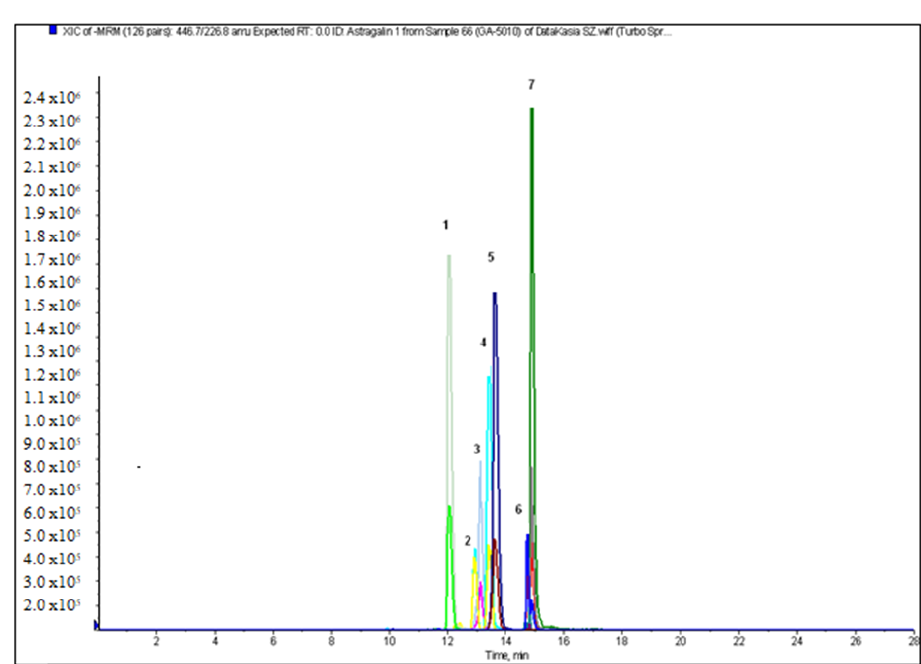
Figure 2. The chromatogram in MRM mode of flavonoid glycosides in the ethyl acetate extract of the aerial parts of A. acutiloba (AH-O): 1-rutin (quercetin-3- O -rutinoside); 2-isoquercetin (quercetin-3- O -glucoside); 3-kaempferol-3- O -rutinoside; 4-narcissoside (isorhamnetin-3- O -rutinoside); 5-astragalin (kaempferol-3- O -glucoside); 6-isorhamnetin-3- O -glucoside; 7-quercitrin (quercetin-3- O -rhamnoside).